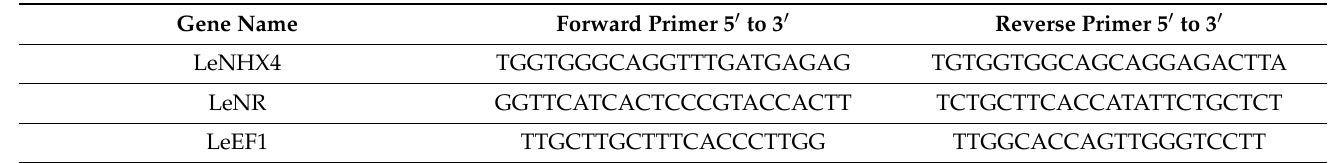
Table 1. The sequence of forward and reverse primers investigated in this